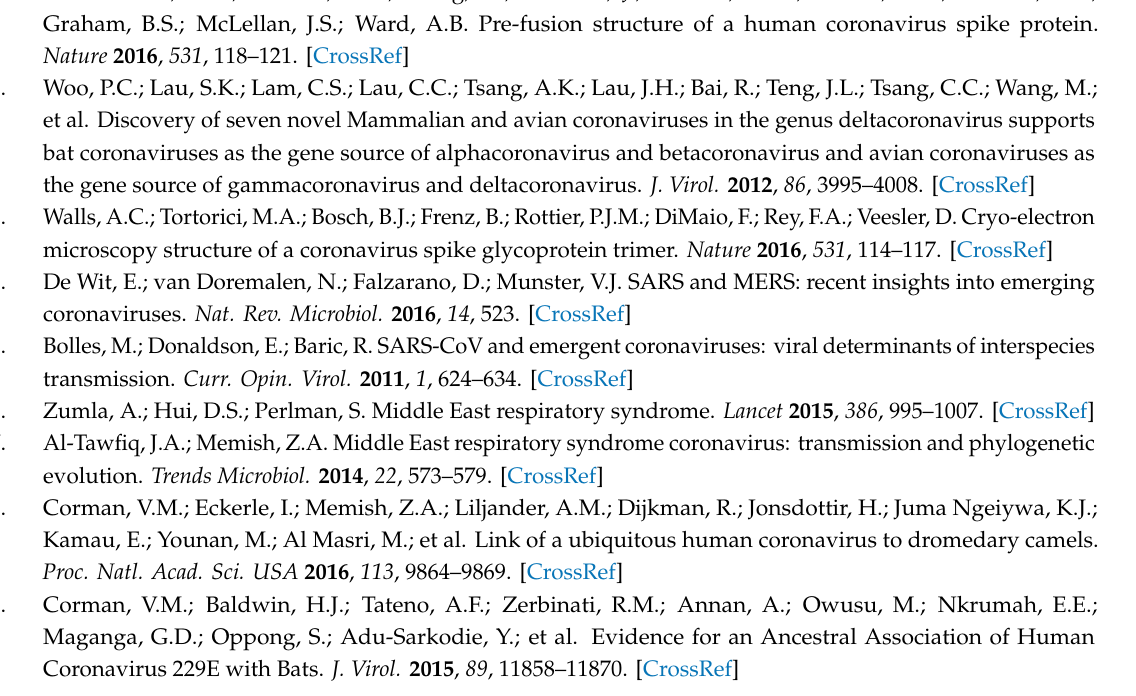
s1, Table S1: ELISA reactivity (OD450 values) of 25 FCoV type 1 specific antisera against S1 antigens of di ff erent